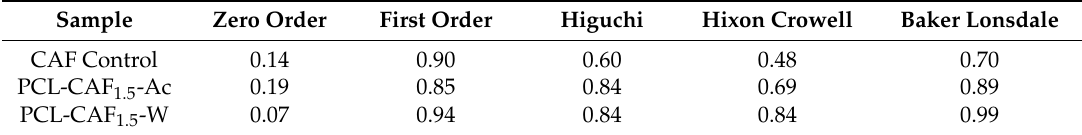
Table 3. Correlation coefficient for fitting of the release curves with different kinetic models.